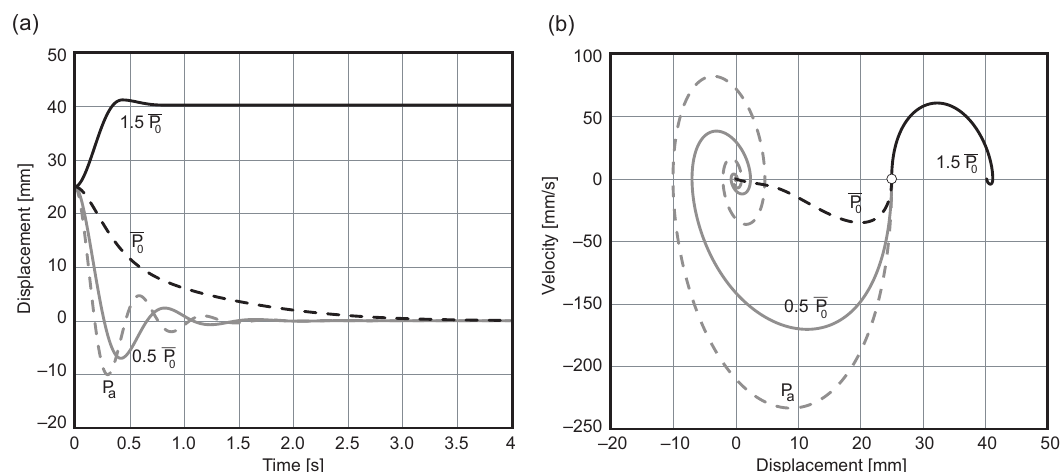
Figure 5. ( a ) Temporal responses and ( b ) phase space trajectories, corresponding to free vibration after an initial displacement of 25 mm, for different initial PLA pressures and a passenger mass of 75